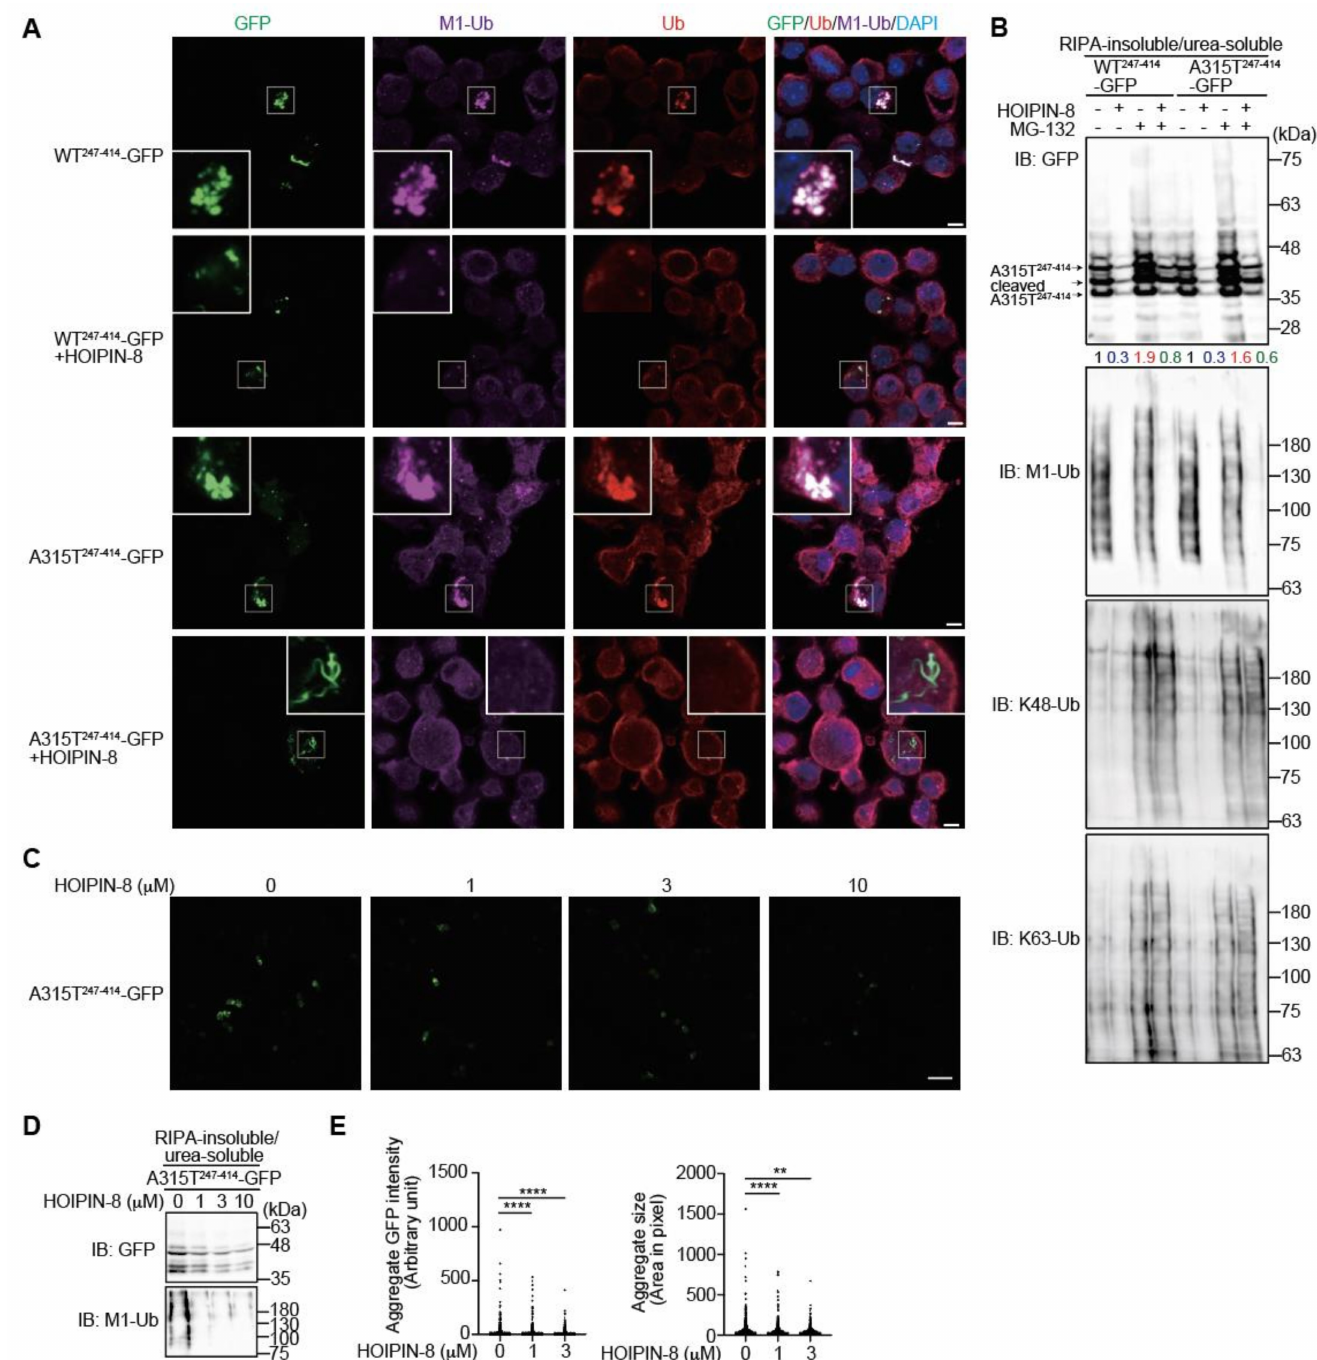
Figure 5. HOIPIN-8 ameliorates truncated TDP-43 aggregation. ( A ) Reduced aggregates of truncated TDP-43 in HOIPIN-8-treated cells. WT 247-414 -GFP or A315T 247-414 -GFP was expressed in Neuro2a cells in the absence or presence of 10 µ M HOIPIN-8 for 20 h, and then immunofluorescent staining was performed with GFP or the indicated antibodies. Bars = 5 µ m. ( B ) A HOIPIN-8-mediated decrease in the insoluble truncated TDP-43. Cells expressing WT 247-414 -GFP or A315T 247-414 -GFP were treated with 10 µ M HOIPIN-8 and/or 2 µ M MG-132, and the RIPA-insoluble/urea-soluble fractions were immunoblotted with the indicated antibodies. Taking the intensity of the control